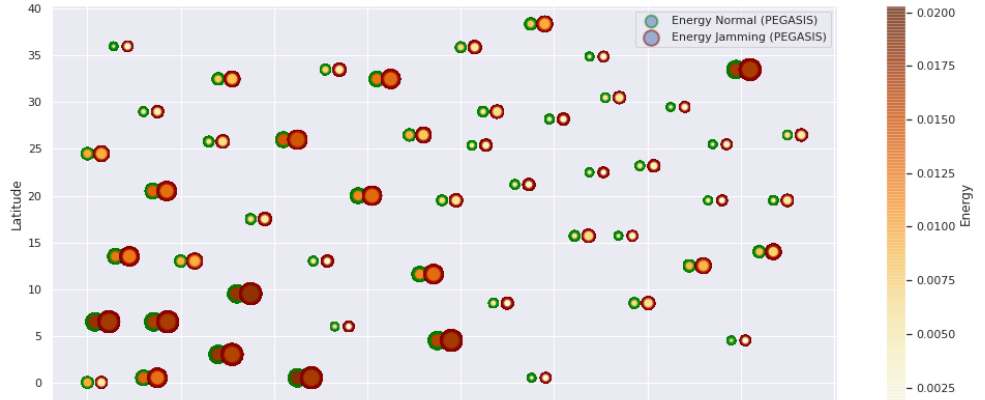
Figure 12. PEGASIS resilience under normal conditions and jamming.